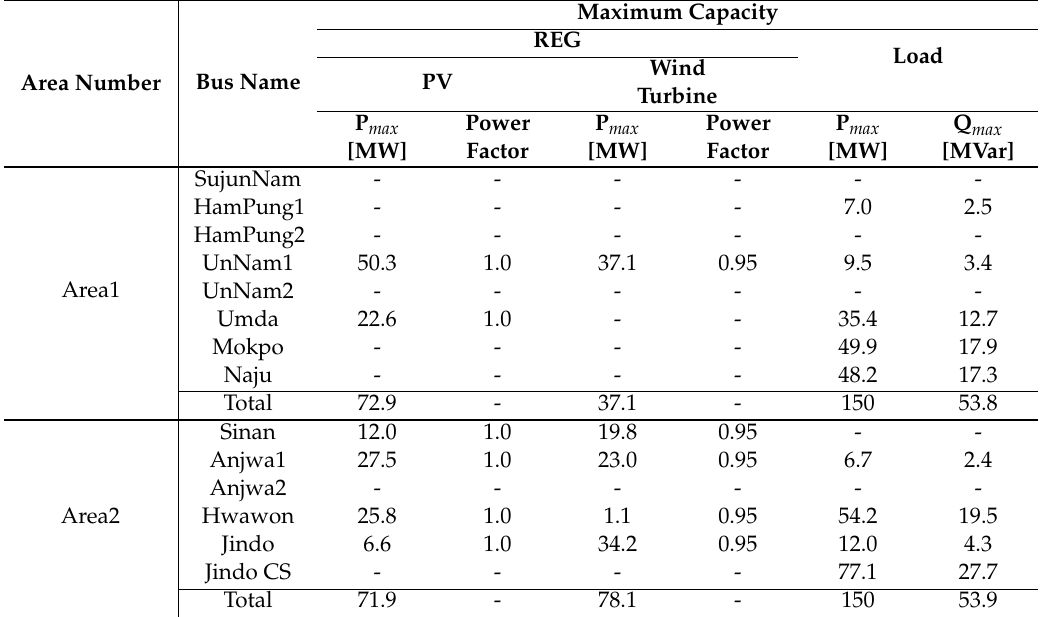
Table A2. Renewable energy generation (REG) and load capacity information.